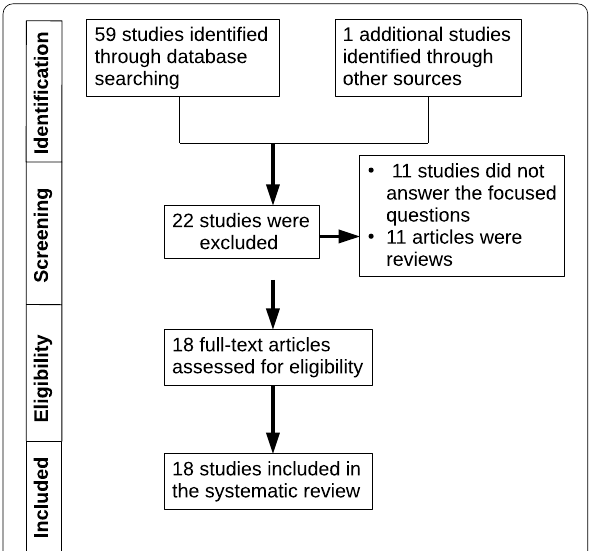
Fig. 2 Flow chart showing the search strategy that was adopted to identify studies that fulfilled the eligibility criteria. This flow chart was constructed in accordance with the Preferred Reporting Items for Systematic Review and Meta‑Analysis